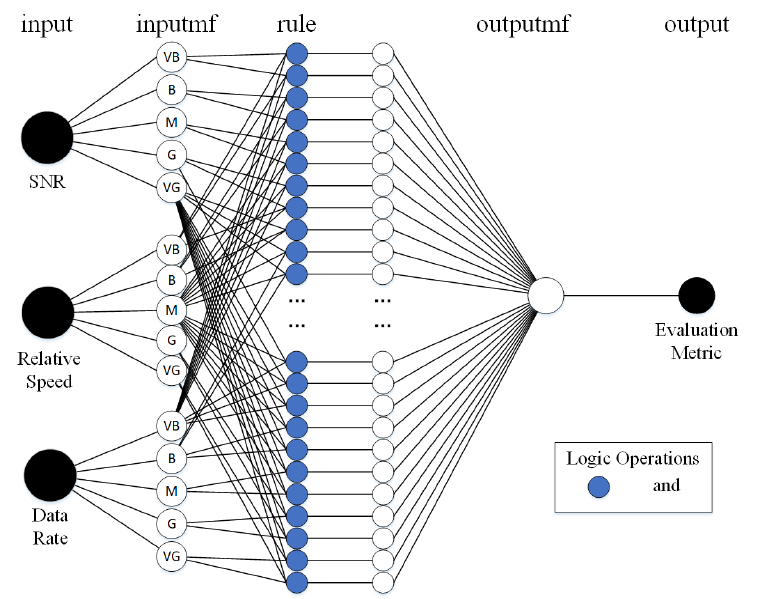
Figure 2. Adaptive neuro fuzzy network